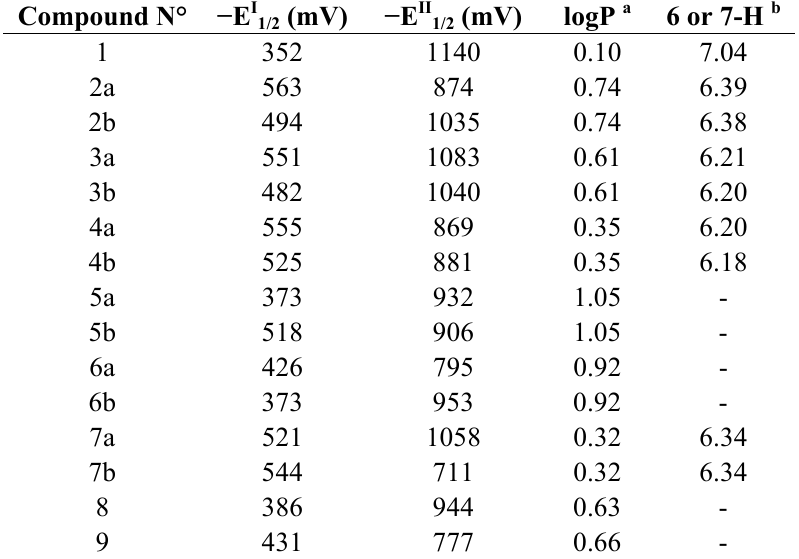
Table 2. Half wave potentials and quinone-proton chemical shifts of 1 and the new